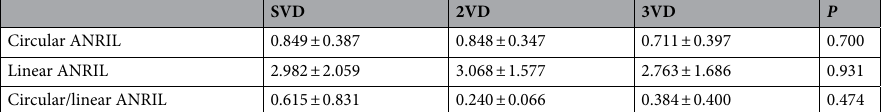
Table 5. The association between atherosclerosis severity and ANRIL expression. SVD single vessel disease, 2VD two vessel disease, 3VD three vessel